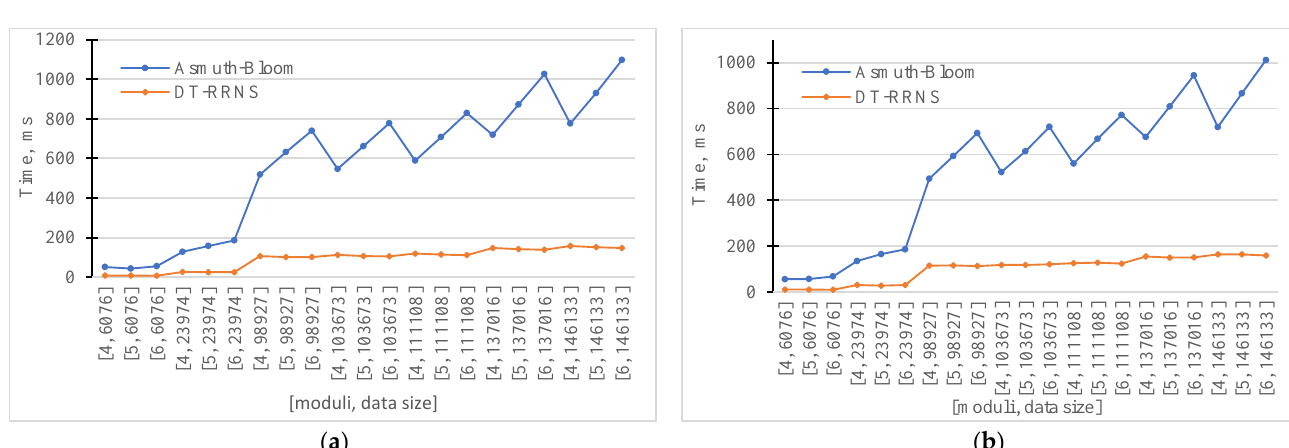
Table 4. Number of moduli and their meanings. Number of Moduli